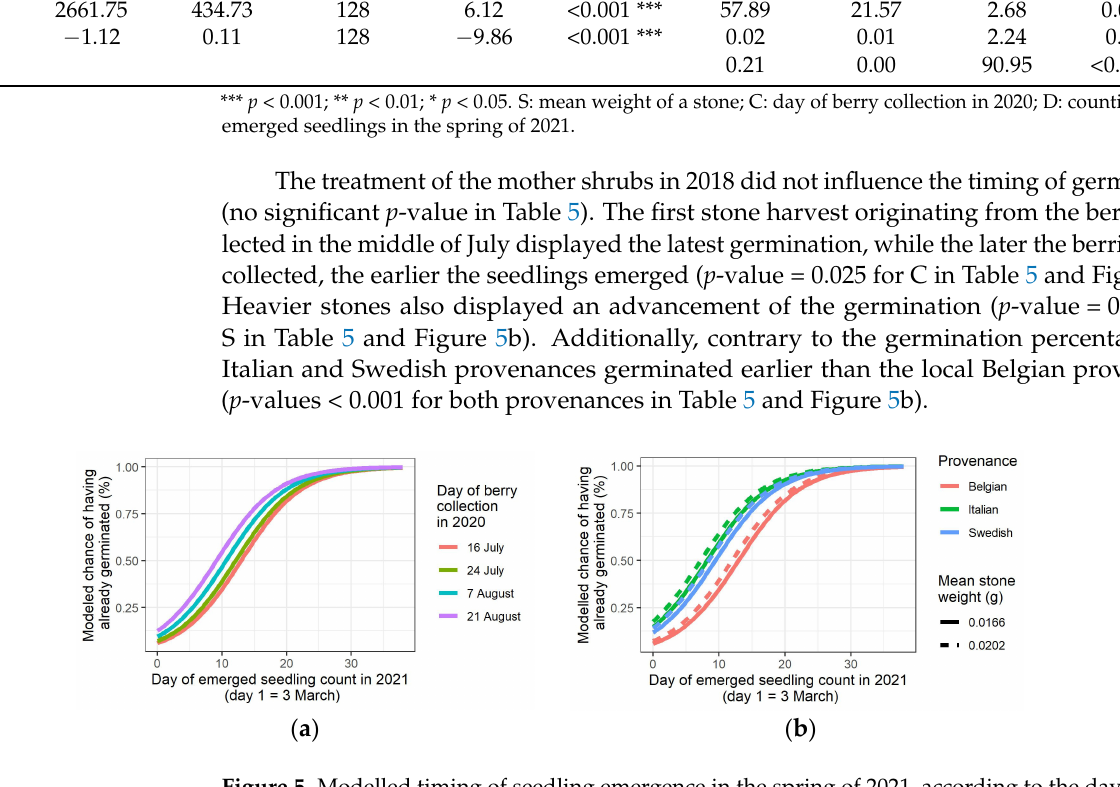
( c ) Figure 6. Modelled timing of bud burst on the mother shrubs in the spring of 2021, according to the provenance ( a ). Scatter plot comparing the modelled days when the chance for seedlings to have emerged was 50% with the modelled days when the chance for the mother shrubs to have reached at least bud burst score 3 was 50%. Linear regression line is shown ( b ). Partitioning of variance for bud burst and seedling emergence in the spring of 2021 ( c ). Table 6. Statistical analysis of the timing of bud burst on the mother shrubs and the timing of seed- ling emergence, both in the spring of 2021. In the model, the Belgian provenance is the standard to which the Italian (It) and Swedish (Sw) provenances are compared. Timing of Bud Burst on Mother Shrubs Timing of Seedling Emergence Variable